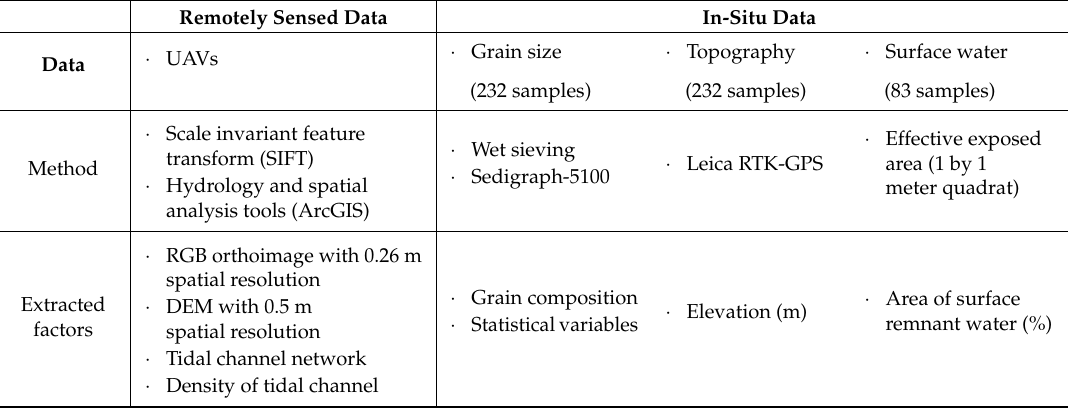
Table 1. List of remotely sensed and in-situ data for classifying the surface sediments. Explanation of the processing method and analysis of the